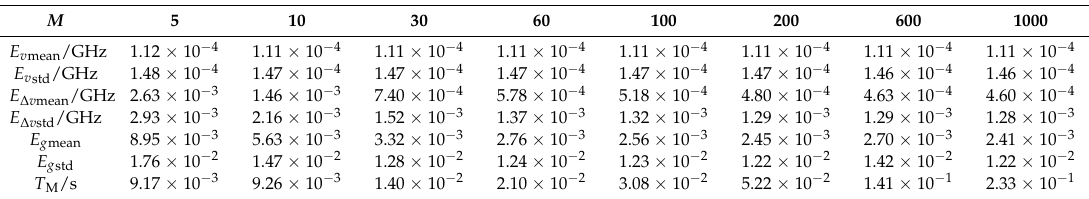
Table 5. Statistical results of errors in the key parameters extracted by the Voigt profile-based algorithm with different numbers of sample points, SNR = 40